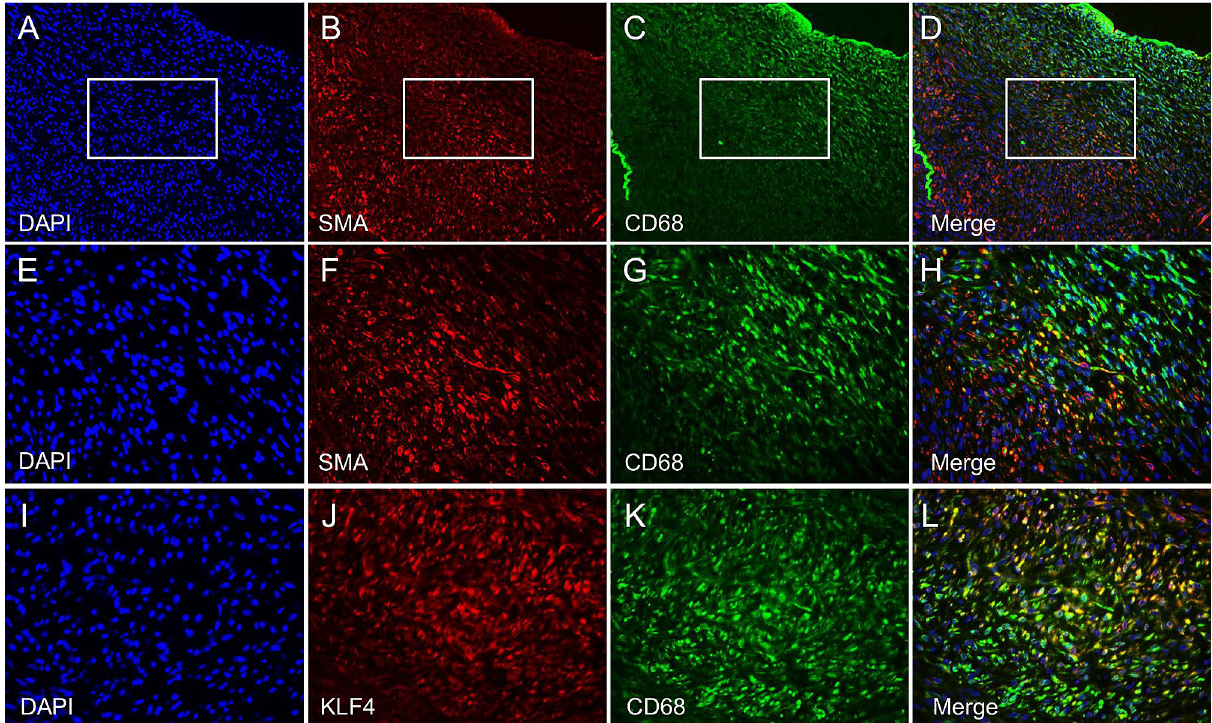
Figure 4. Alpha smooth muscle actin (SMA) positive cells and cluster of differentiation 68 (CD68) in the intimal hyperplasia lesion of nicotine injection with balloon overdilation group. ( A – D ) In the hyperplastic lesion of nicotine injection with balloon overdilation groups, SMA positive cells and CD68 positive cells were separately observed. ( E – H ) An examination at higher magnification, board zone revealed SMA and CD68 co positive cells. ( I – L ) CD68 positive cells co expressed